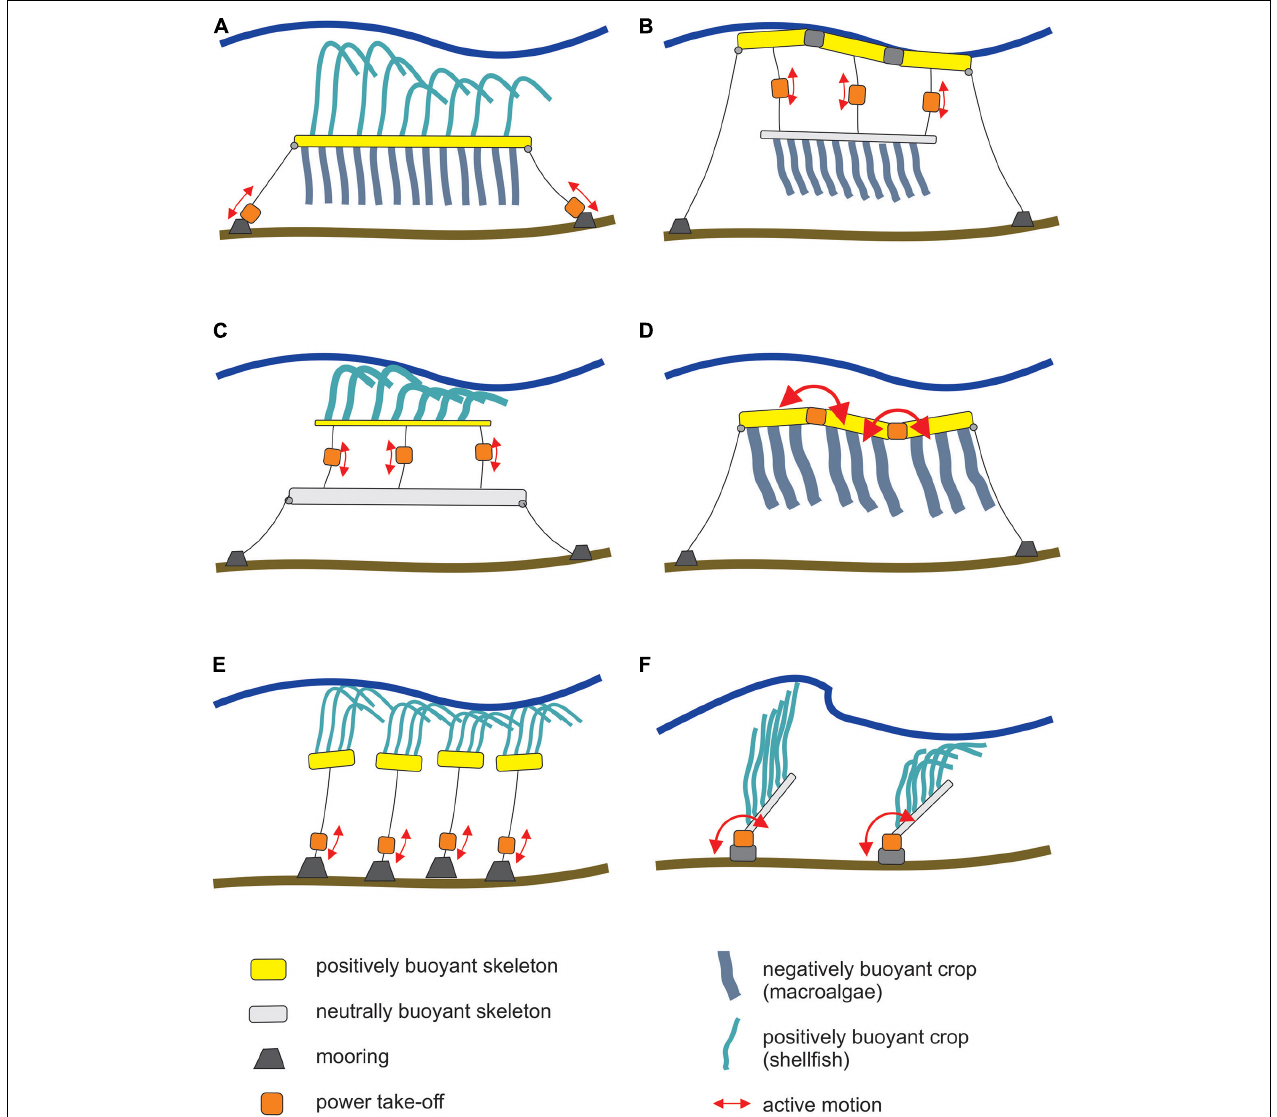
FIGURE 6 | Potential configuration options showing (A) equivalent to Figure 1 , (B) suspended shellfish, (C) moored macroalgae, (D) “Pelamis equivalent,” (E) heaving buoy, and (F) hinged flap approaches. As a visual aid, the amount of crop has been de-emphasized relative to the structural